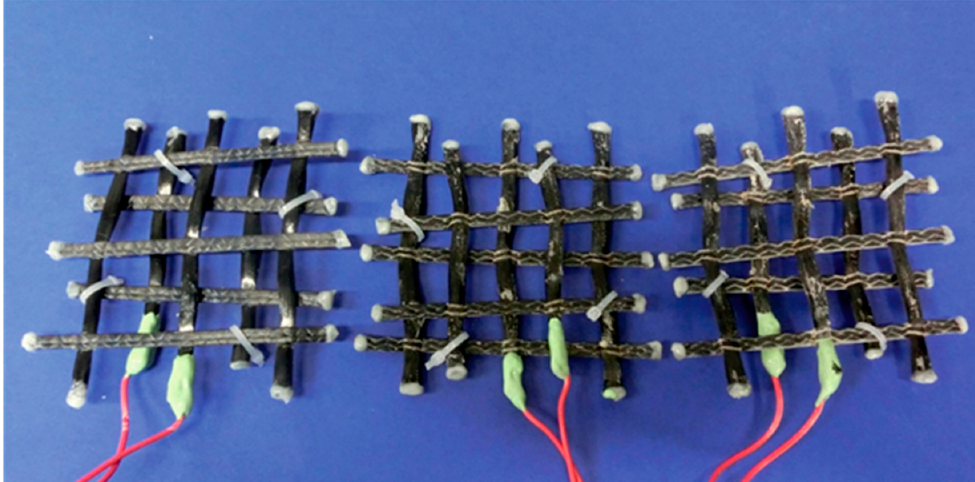
Figure 9. From left to right: S4 anodes of stages 1 to 3 after